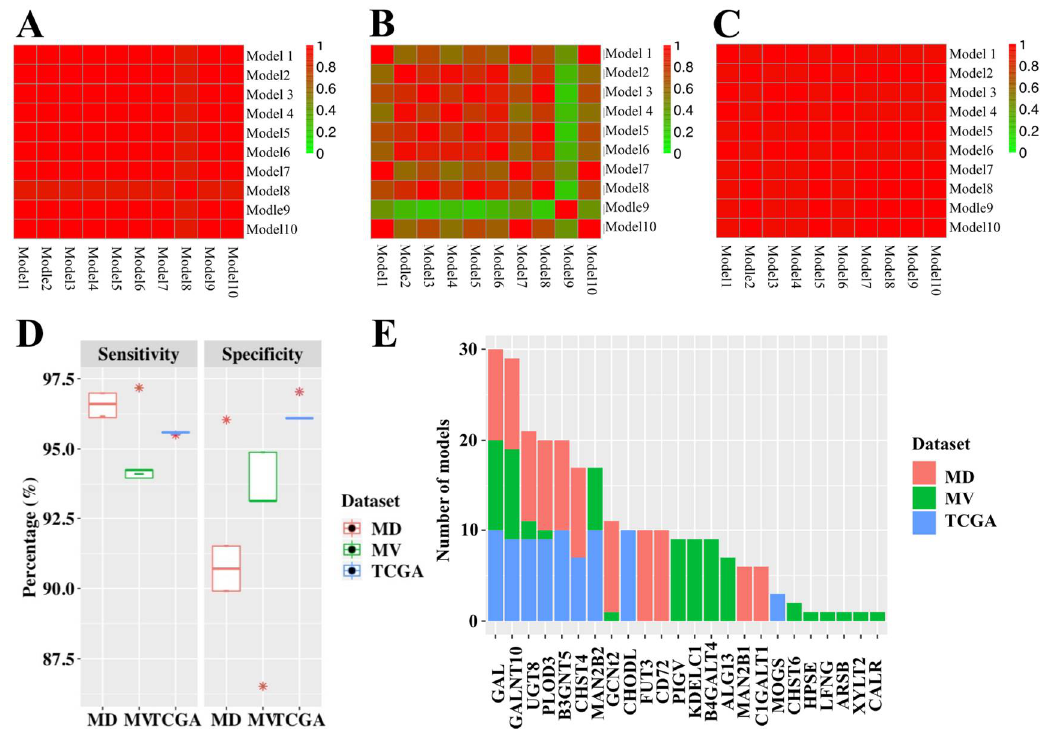
Figure 5. Discovery of TNBC predictive glycogenes. Accuracy and reproducibility of the ten TNBC predictive models for each dataset for ( A ) METABRIC discovery, ( B ) METABRIC validation and ( C ) TCGA. The colour bar indicates the similarity between any two models. ( D ) Distribution of sensitivity and specificity for the predictive models for each dataset. ( E ) Bar chart of frequency of all predictive genes in these 30 models. MD, METABRIC discovery; MV, METABRIC validation. * p < 0.05.